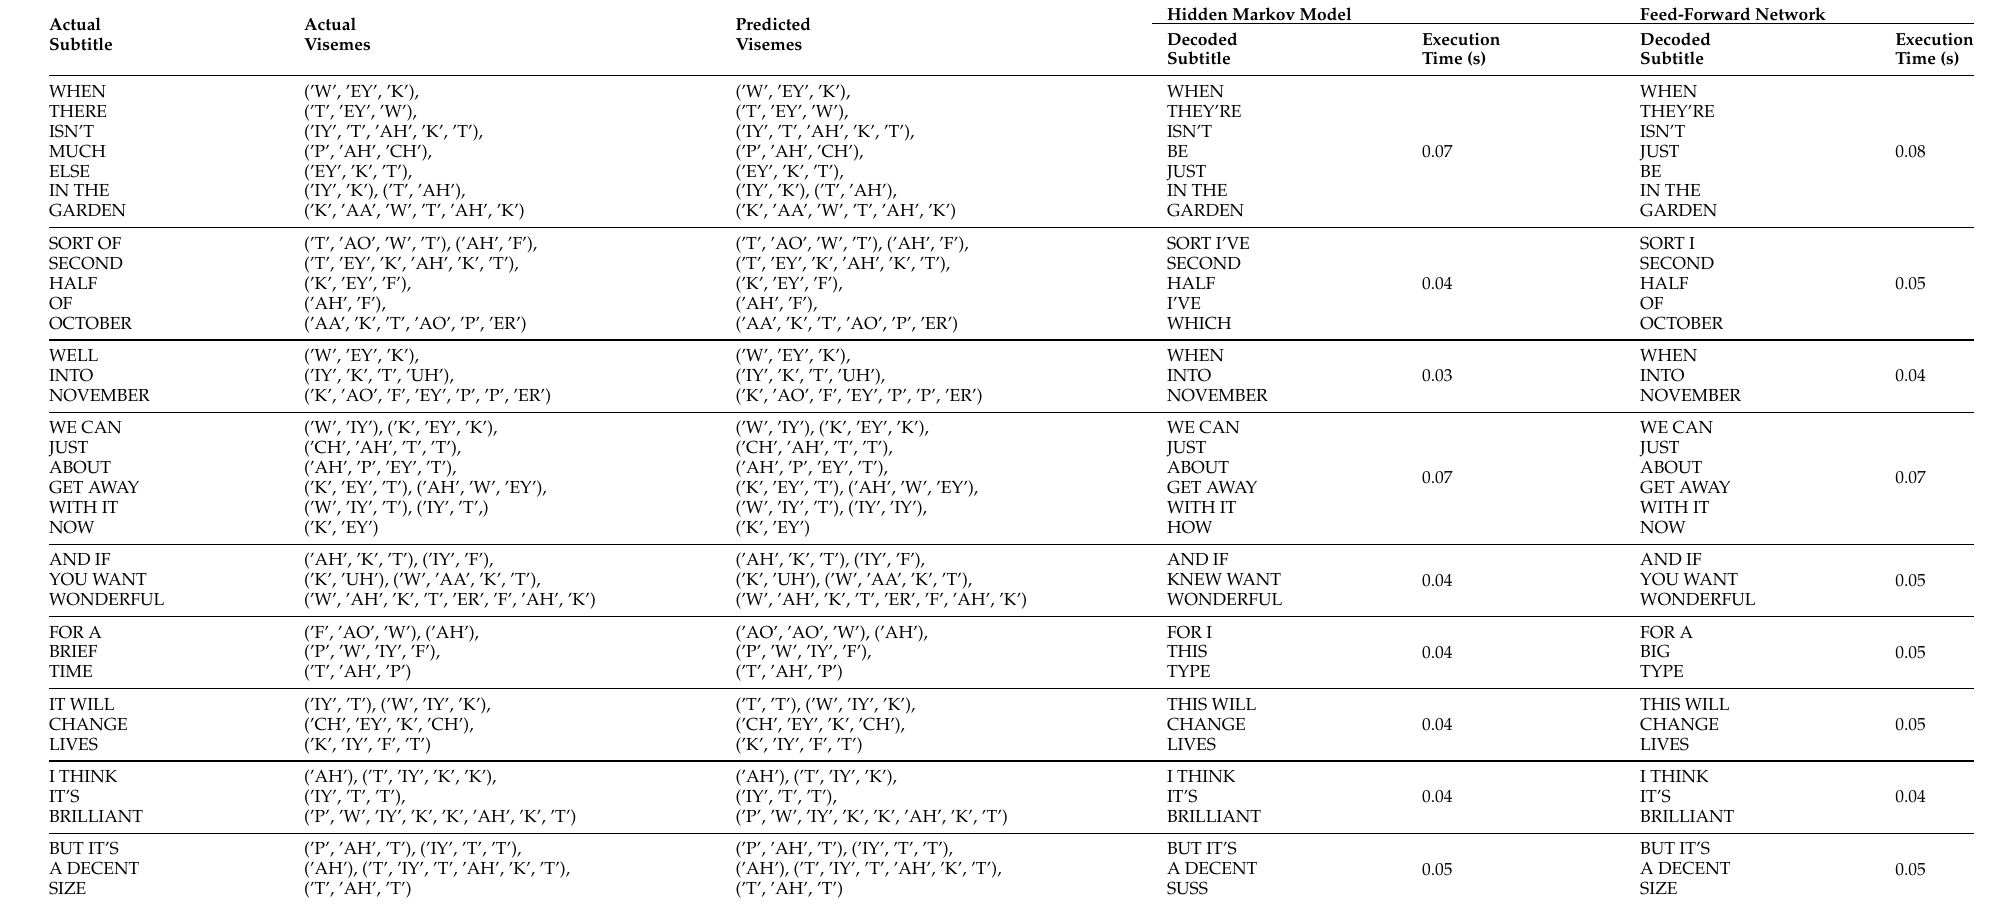
Table 10. Examples of decoded sentences from the two viseme-to-word